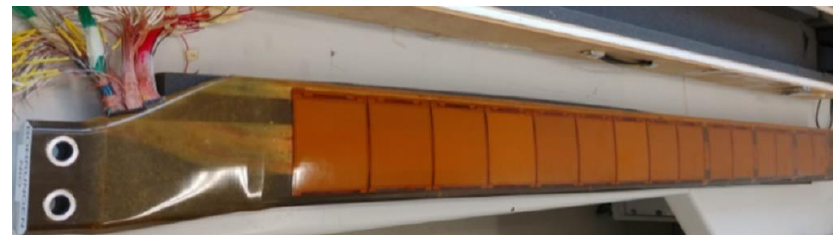
Figure 1. STAR blade used for X-ray CT scan and structural property